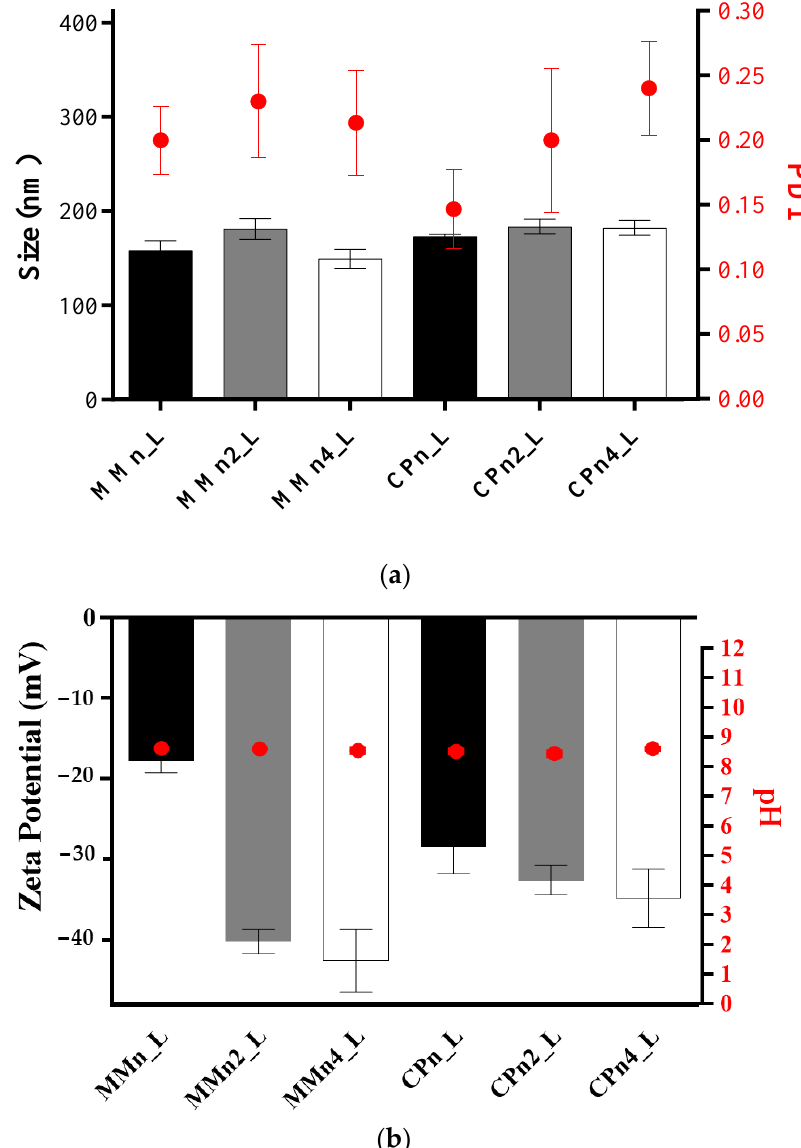
Figure 1. Structural properties of hybrid systems, with and without AO (0–4%, wt). DLS measure- ments prepared after 24 h samples are shown in terms of ( a ) size (nm), polydispersity index (PDI), and ( b ) zeta potential and pH values. Data are presented as mean ± standard deviations ( n = 3).